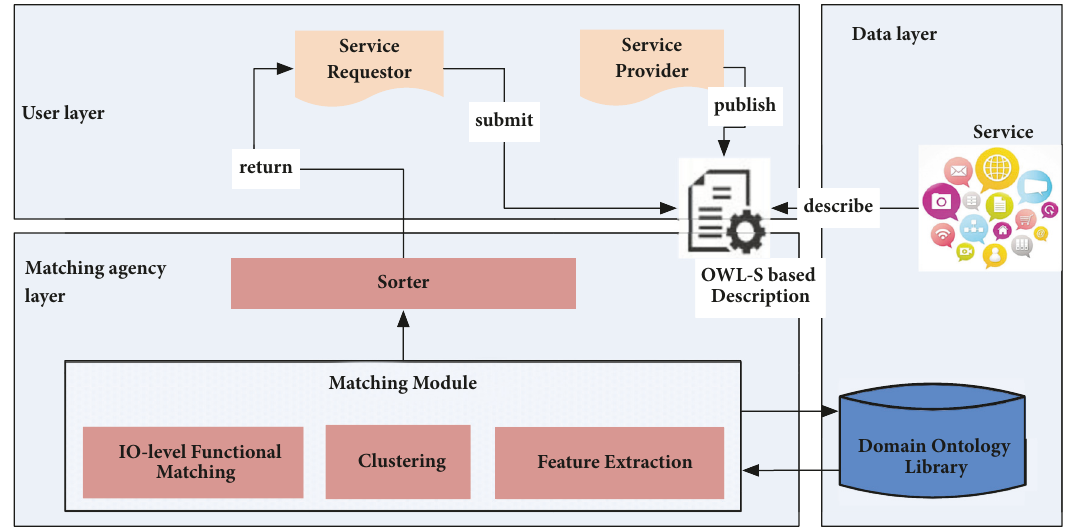
Figure 1: Proposed architecture.